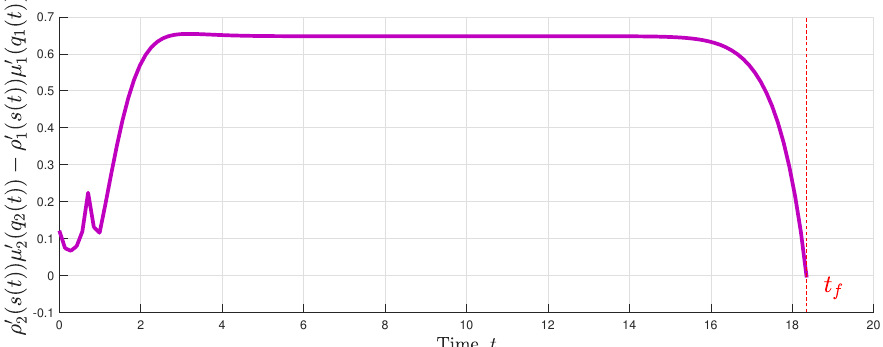
( s ( t )) µ (cid:48) ( q ( t )) − ρ (cid:48) ( s ( t )) µ (cid:48) ( q ( t )) along the optimal trajecto- 2 1 2 2 1 1